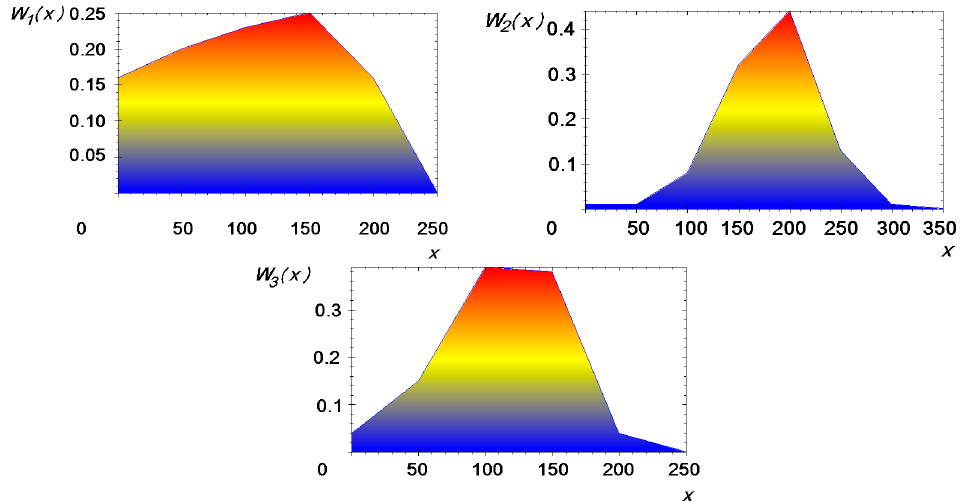
Figure 1. Graphs of the experimental probability density of traffic intensity at fixed times t 1 , t 2 , t 3